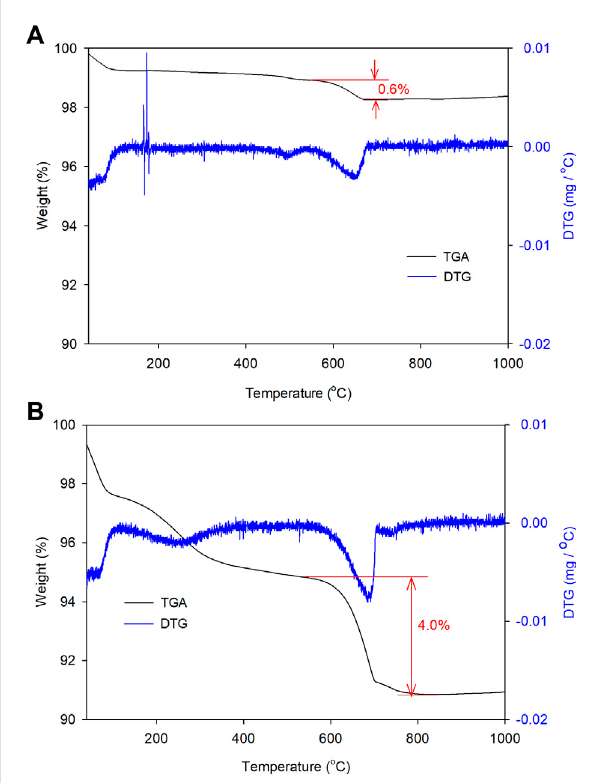
FIGURE 5 TGanalysisresultsofsolidsamplescollectedafterbasaltreaction at 200 ° C in 0.5 mol/L NaHCO 3 solution for (A) 5 days and (B) 10 days (Runs 2 and